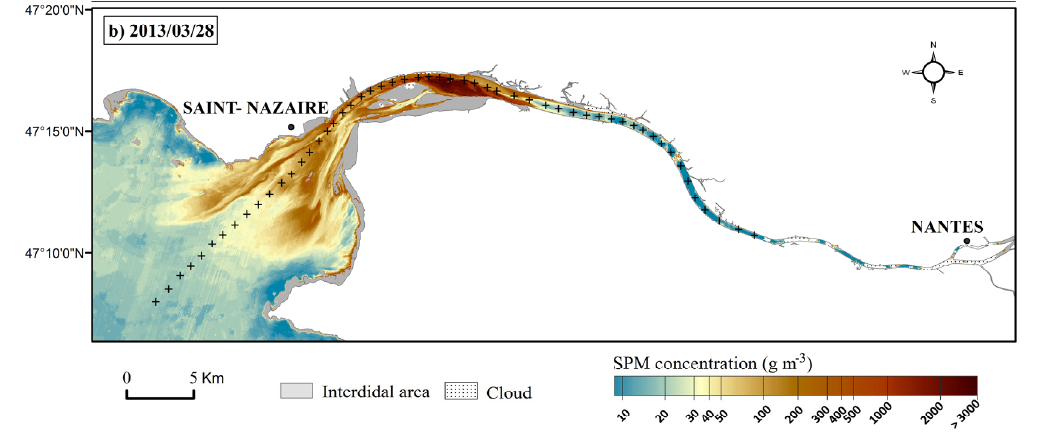
Figure 6. ( a ) SPOT4 suspended particulate matter (SPM) concentration in the Loire estuary during neap tide on 21 February 2013; ( b ) SPOT4 SPM concentration during neap tide on 28 March 2013. The crosses show the location of transect pixels used in Figure